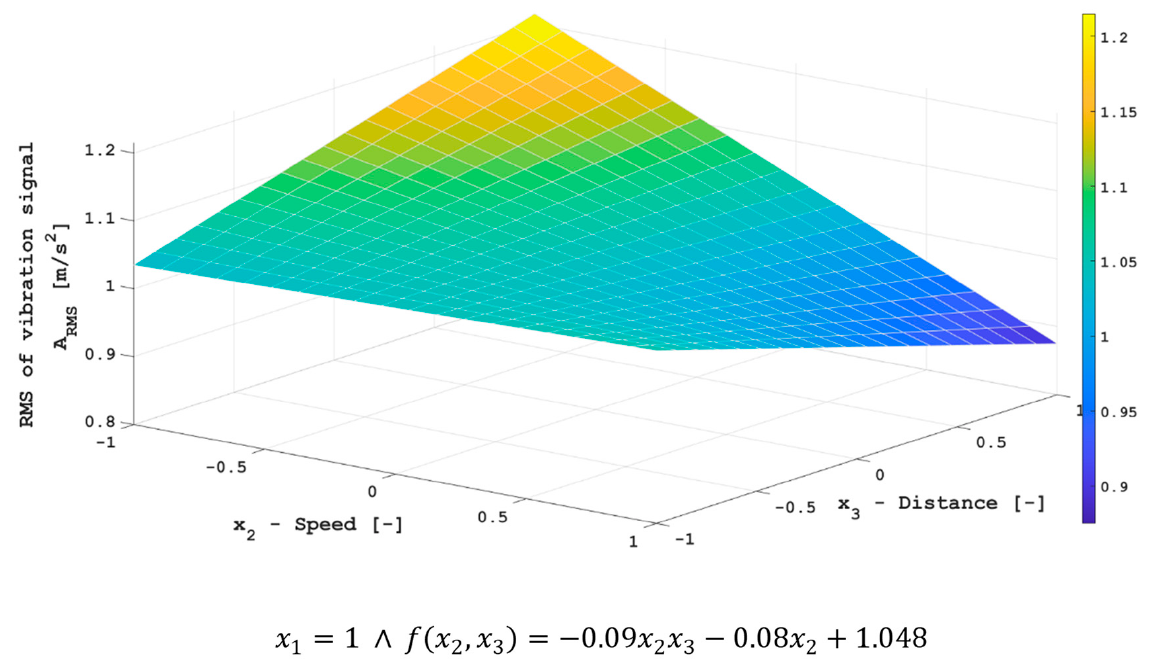
Figure 5. A RMS signal values, depending on the speed of the electric scooter and the distance traveled when moving on paving stones.